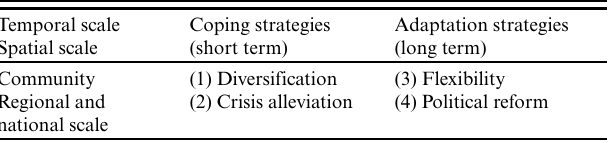
Table 1 . Temporal and spatial aspects of community responses to social-ecological